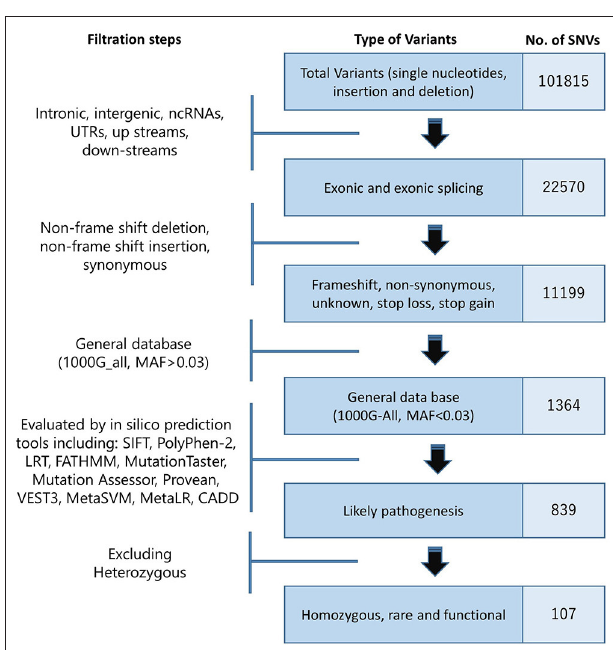
FIGURE 2 | Filtrating steps to identify variant associated with the phenotype. (SNV: single-nucleotide variant).